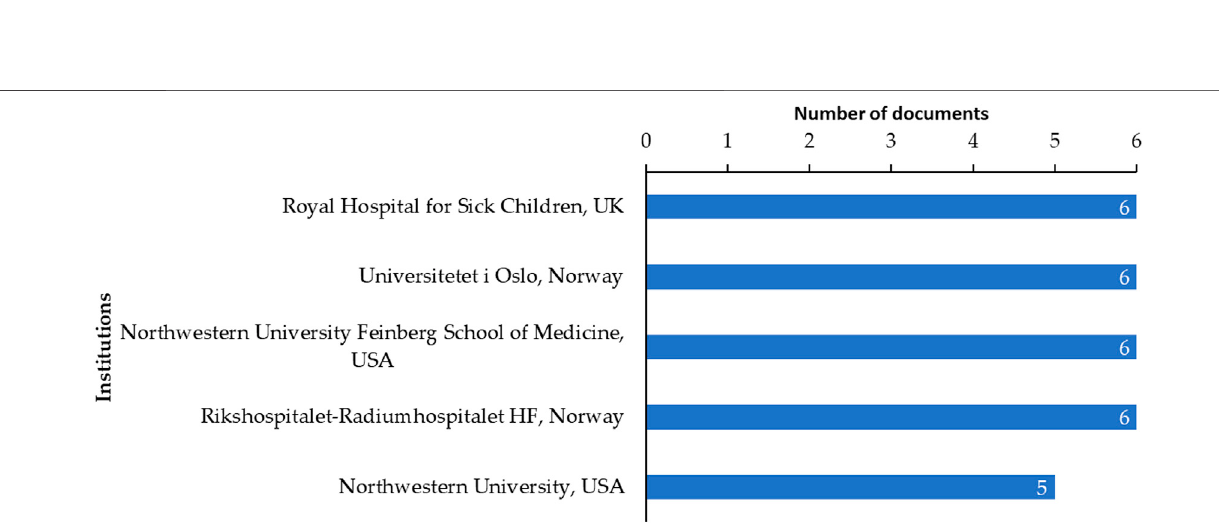
Frontiers in Cell and Developmental Biology |